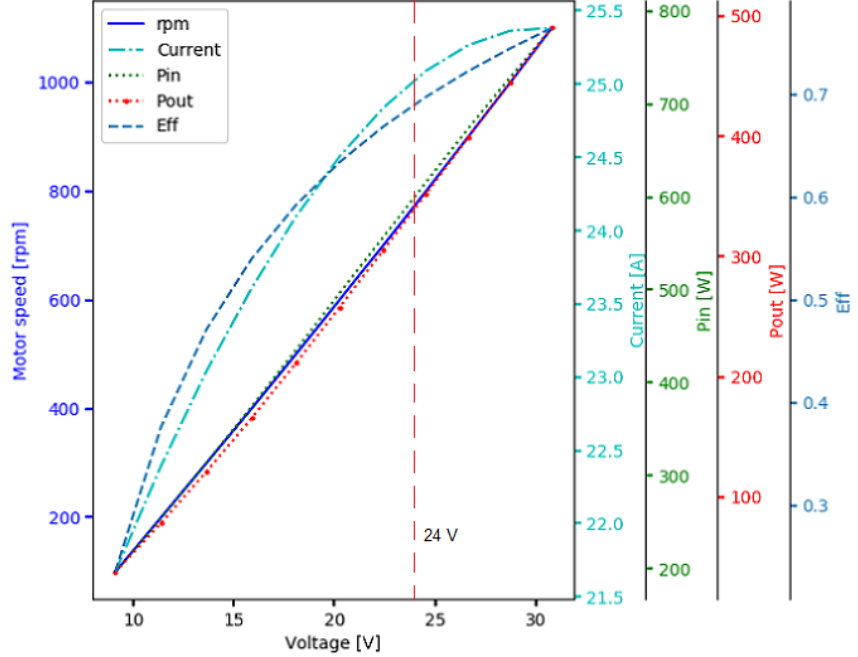
Figure 15. The motor behavior with respect to speed and its corresponding parameters when the motor is powered with different voltage levels and the applied load is set to 100 kN. The red dashed line shows the level of the nominal voltage supplied by the